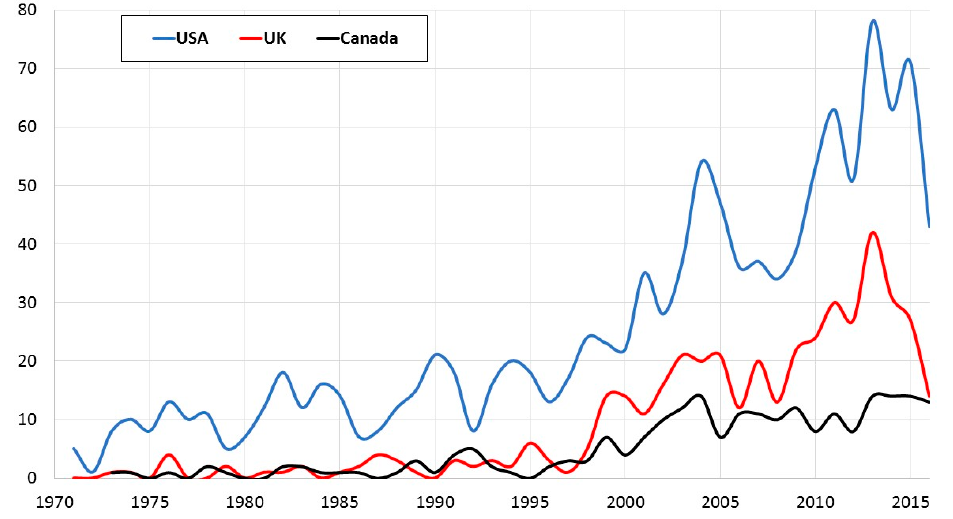
Figure 5. Trends in publications on labour relations from 1970–2016 for the Top 3 countries.